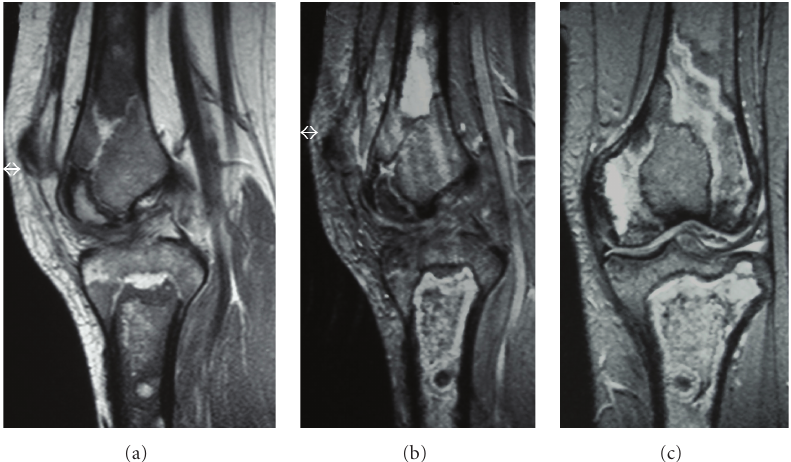
Figure 6: (a), (b) and (c) T1W sagittal, T2W sagittal, and coronal MRI knee in a patient with sickle cell anaemia showing, low signal change on T1W images with corresponding areas of solid and serpiginous high signal change on T2W sequence consistent with medullary infarcts involving the femur and